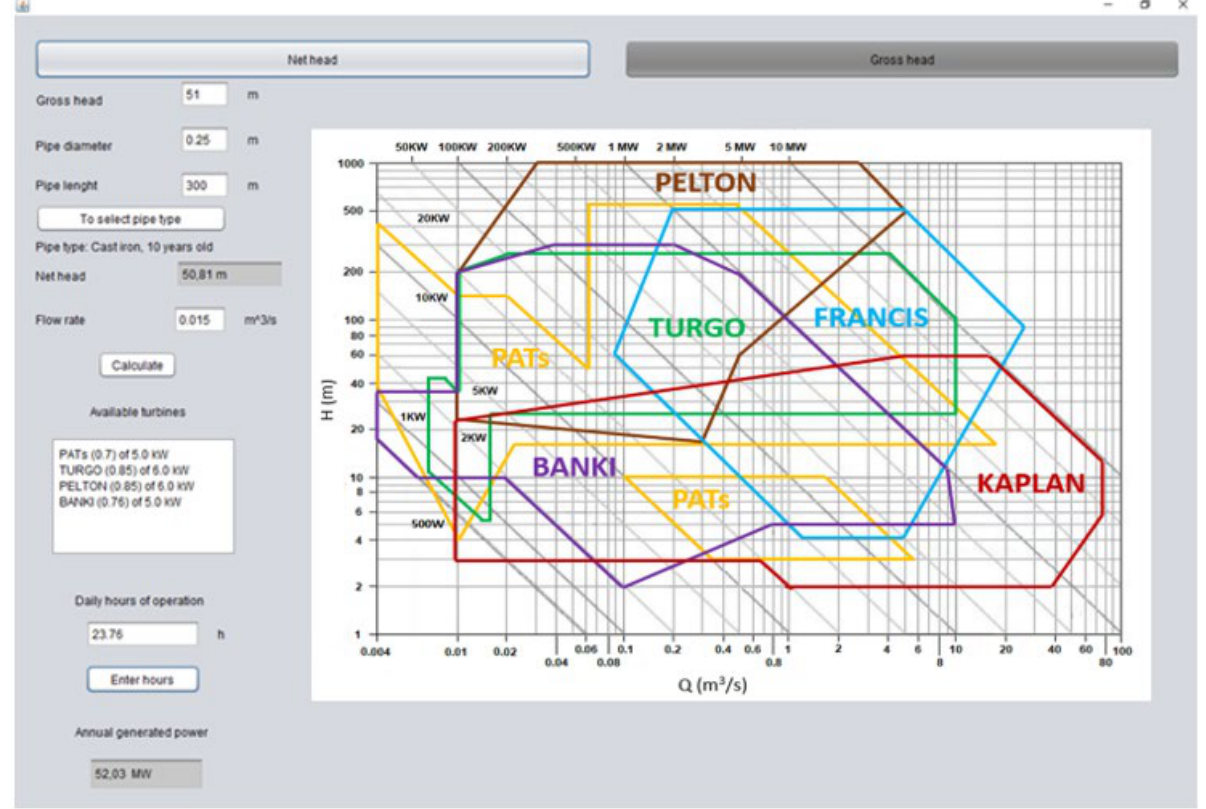
Figure 6. Main window of the computer application developed: results of case study 4.